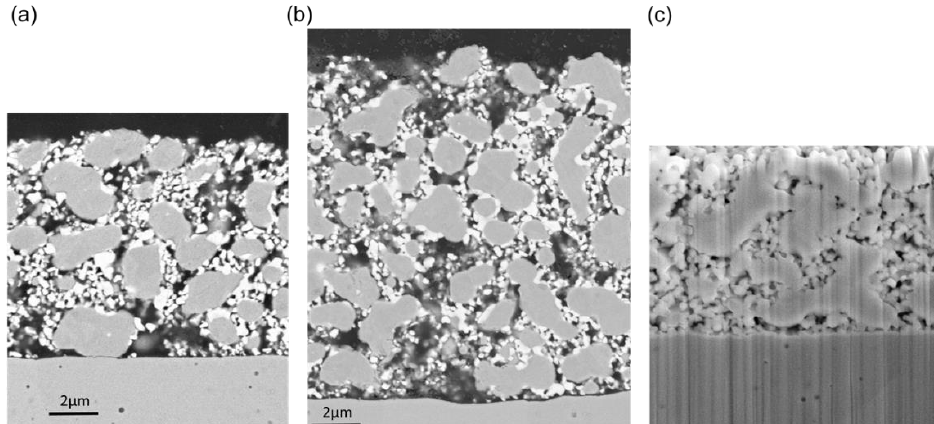
Figure 8. SEM images of the anode cells after electrochemical characterization with ( a ) 8-µm and ( b ) 14-µm-thickness and ( c ) with a GDC thin film deposited before electrode screen printing. Due to the used backscatter electron detection in the figure parts a and b, chemical contrast allows differentiation between GDC (bright) and Ni (grey) particles.